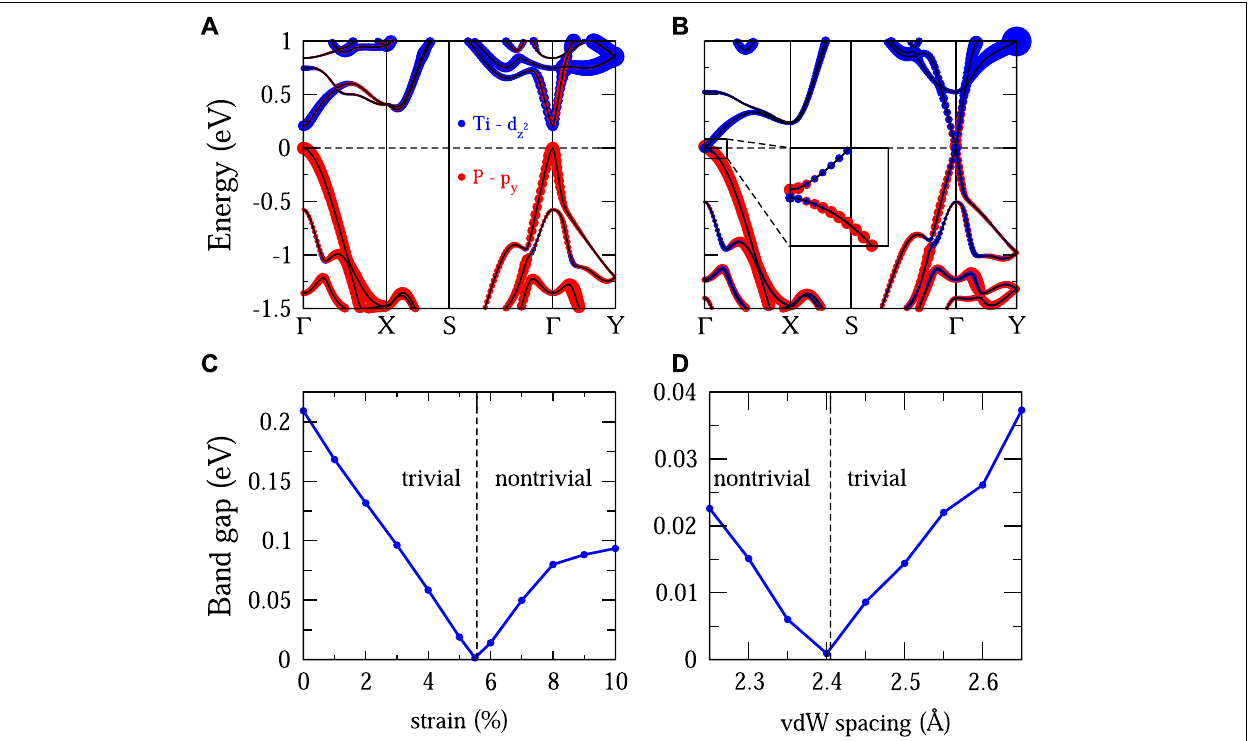
FIGURE 3 | (A , B) The band structure of strain-free single-layer TiPI and 6% uniaxial strained single-layer TiPI, respectively. The inset in (B) shows the band inversion around Γ . The color representation is shown in (A) for both cases. (C) The magnitude of band gap of single-layer TiPI versus strain. (D) The magnitude of band gap of bilayer TiPI versus the vdW spacing.